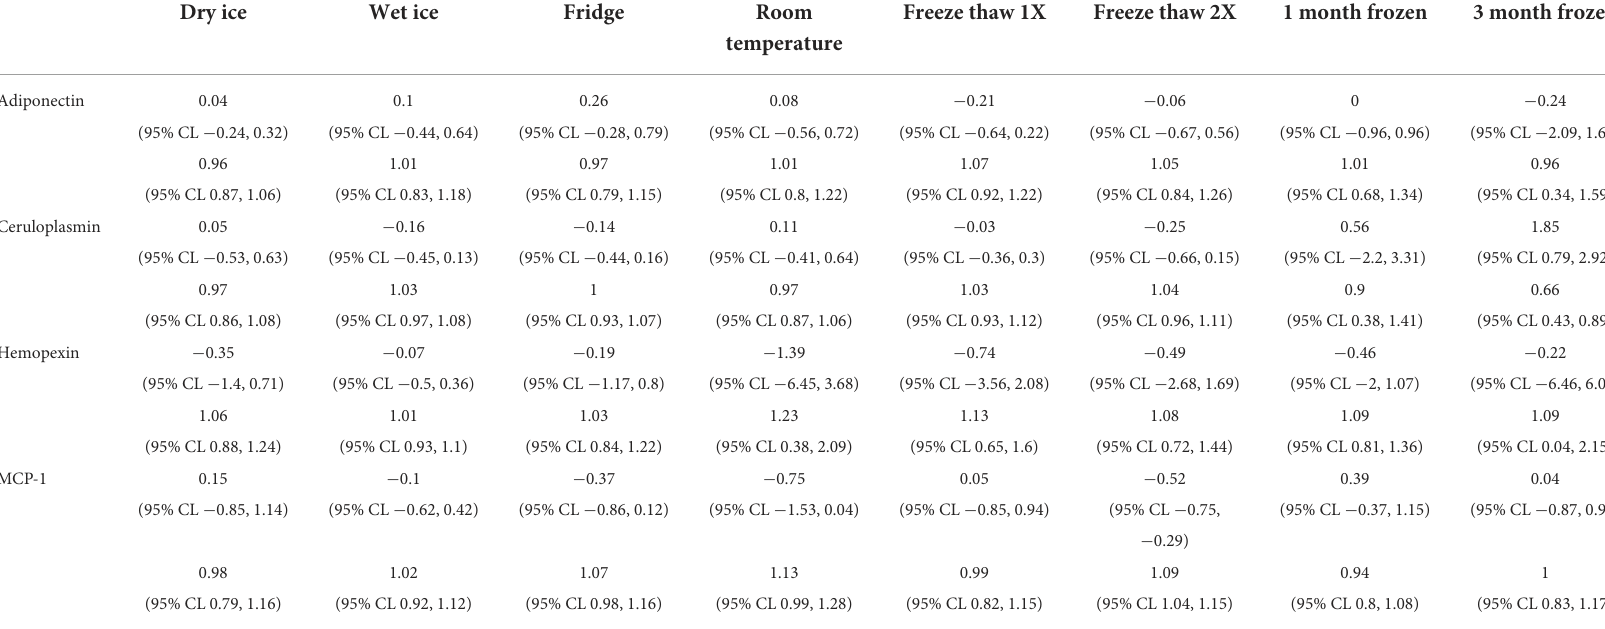
TABLE 2 Deming-Regression Intercept and beta-coefficient for each biomarker under each experimental